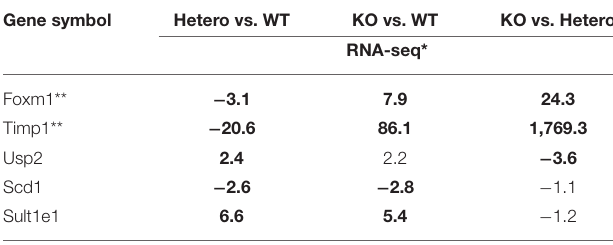
TABLE 3 | The selected 5 DE genes in comparison between Phb1 − / − , Phb1 + / − , and